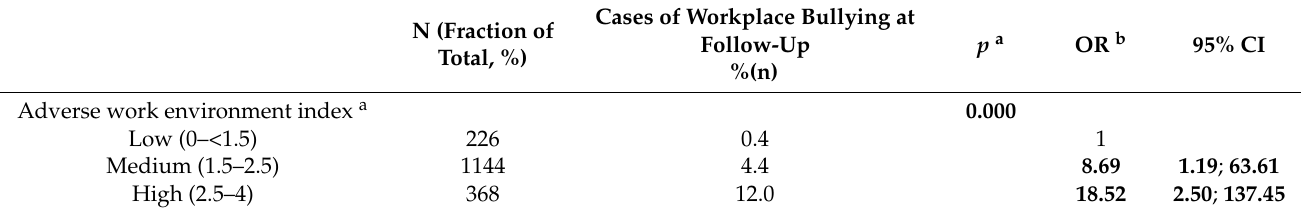
workplace bullying. b Adjusted for baseline workplace bullying and occupational